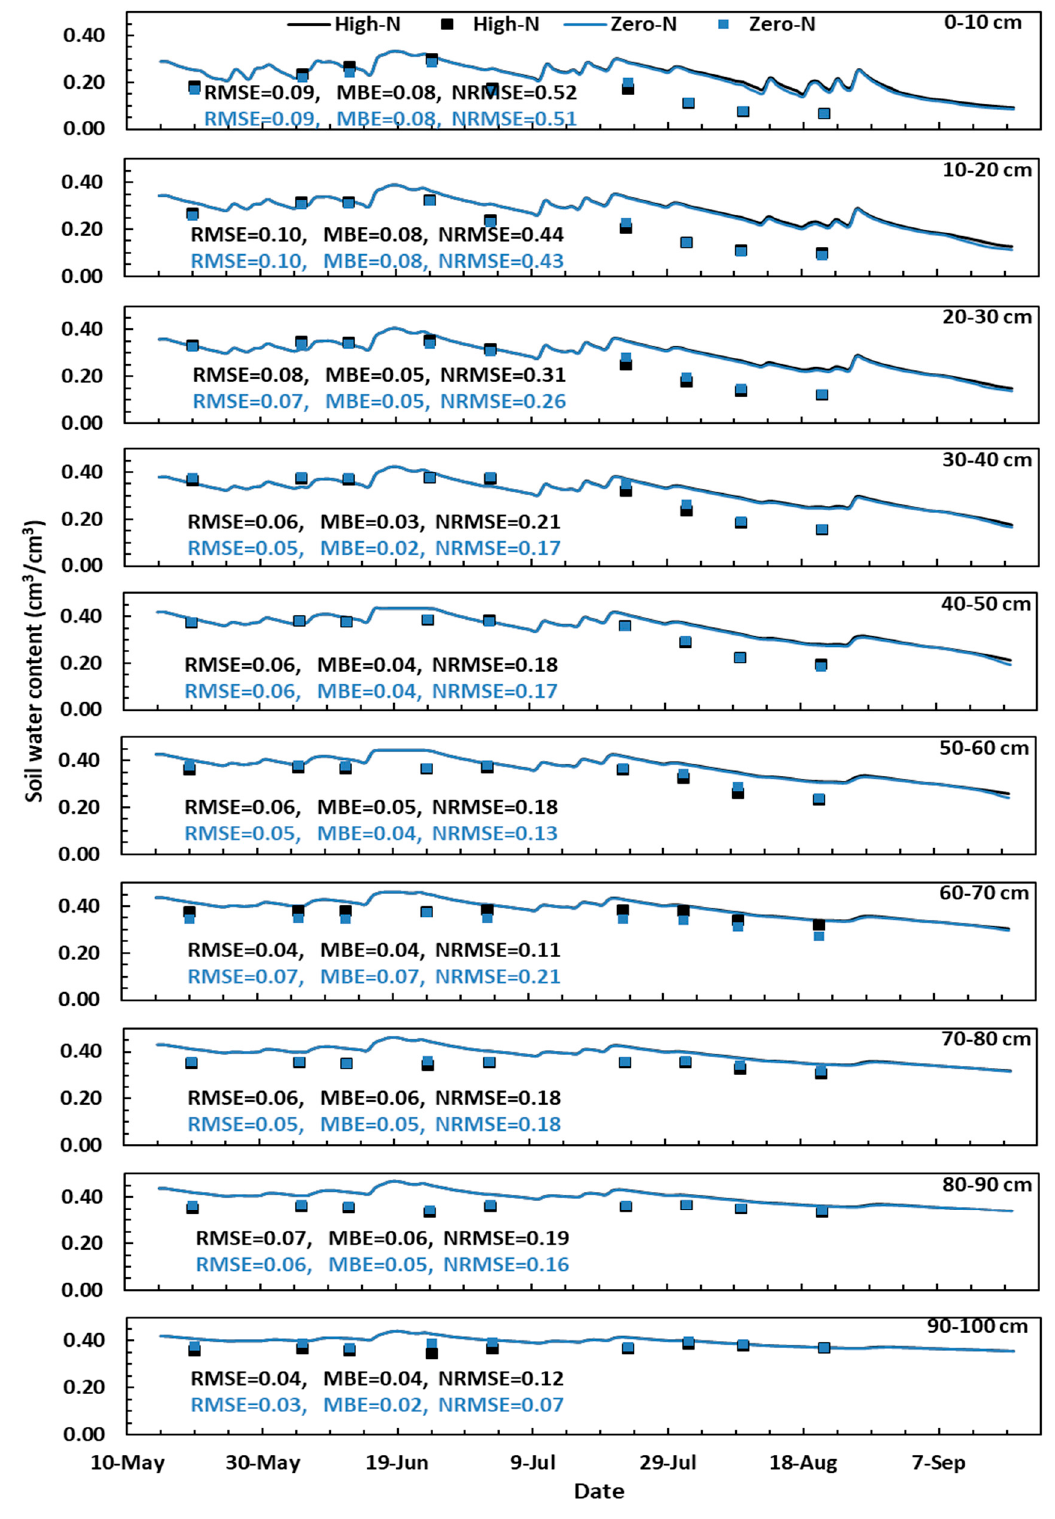
Figure 4. Model-simulated vs. field-measured soil water content with time in different soil layers for the high N and zero N rates during the corn growing season under 100% rainfall.